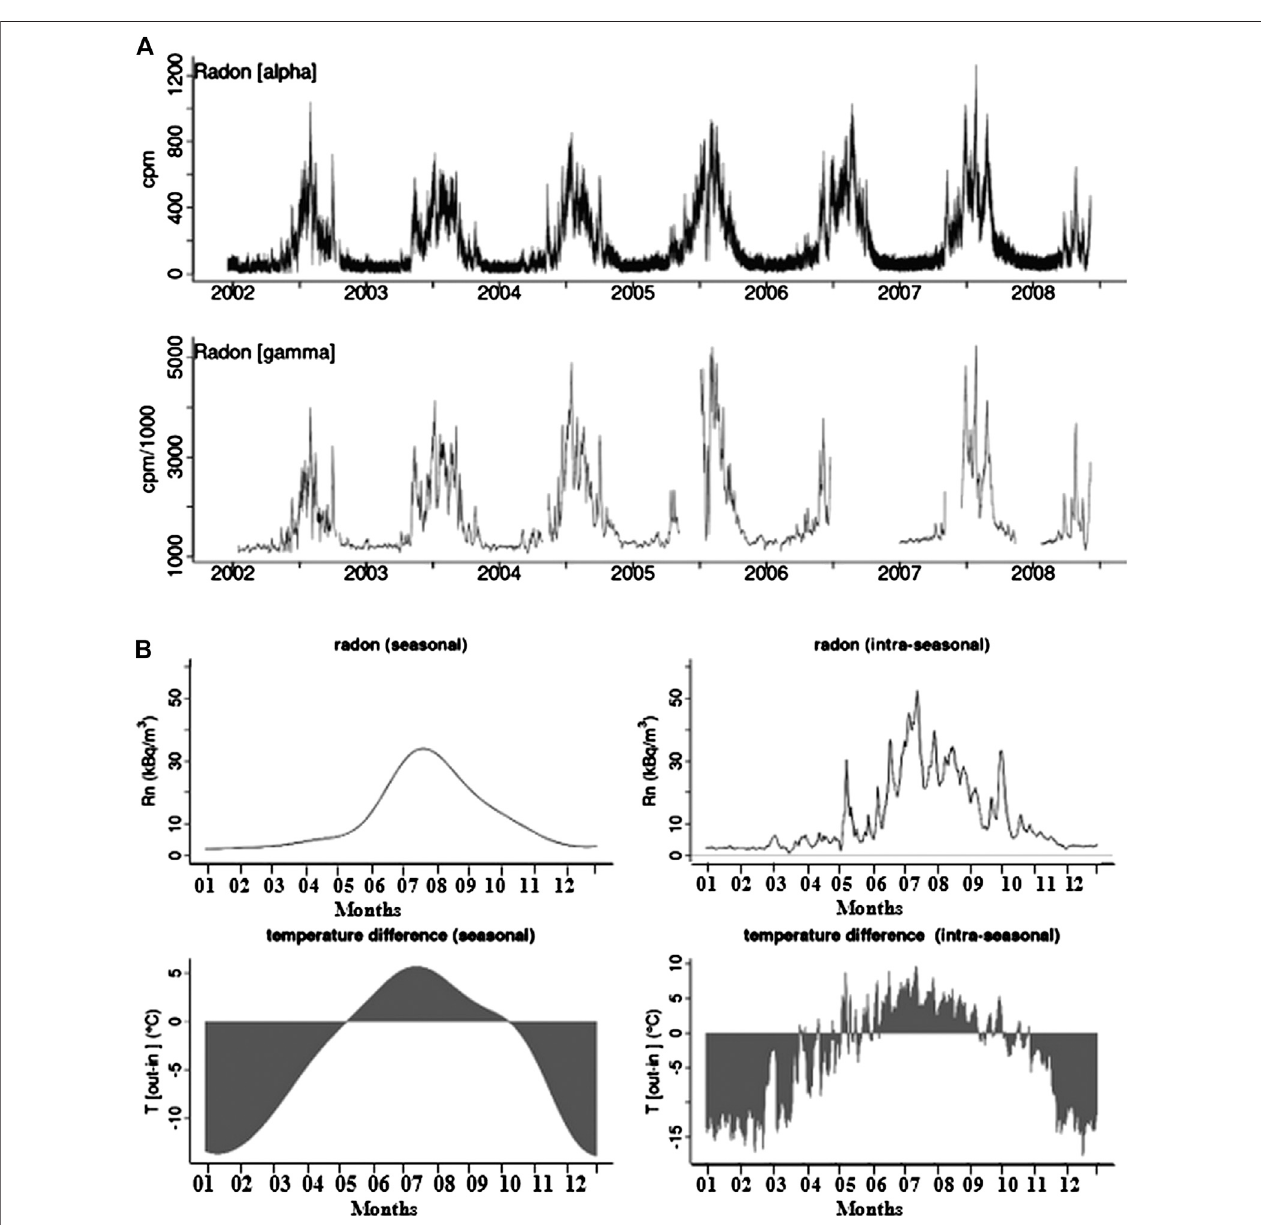
FIGURE3| Time-seriesofmeasurementsattheAmramtunnel(15-mintemporalresolution),fromtoptobottompanels: (A) Radonbygamma,andradonbyalpha) during 6 years. (B) (left) The similarity between the two seasonal patterns becomes evident when considering the difference between the external temperature and the constant temperature inside the tunnel (temperature gradient). (B) (right) The intra-seasonal variability is also associated with changes in the temperature gradient between the inner part of the tunnel and the outside environment.